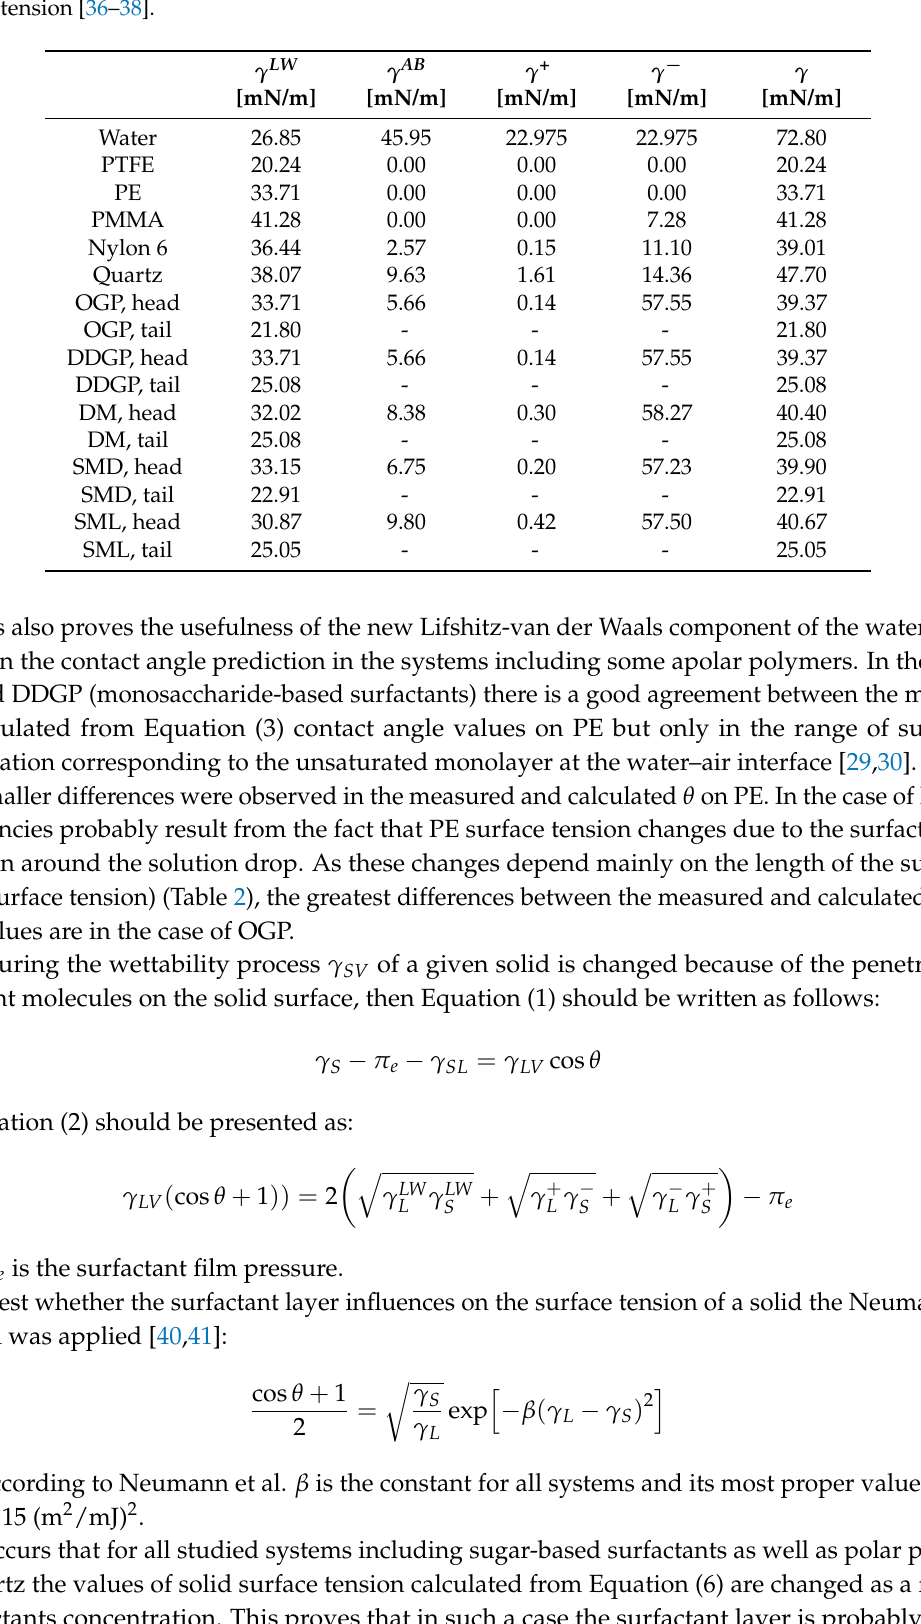
Table 2. The values of water, solid and surfactant surface tension ( γ ), the Lifshitz-van der Waals ( γ LW ) and acid-base component, as well as the electron-donor ( γ − ) and electron-acceptor ( γ + ) parameters of this tension